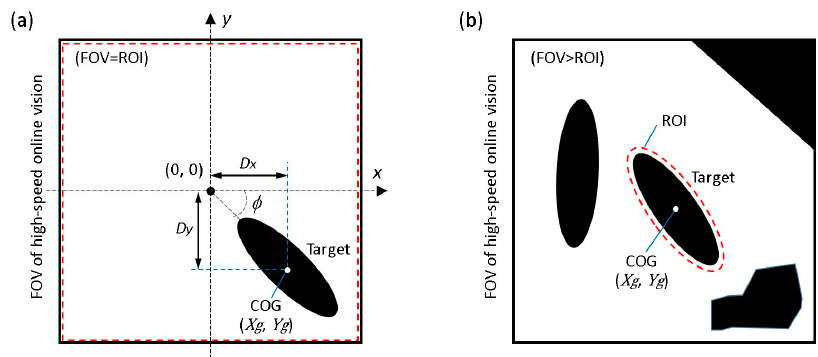
Figure 3. Image coordinate system for image processing. ( a ) Typical image processing for target tracking; ( b ) Implemented approach with an elliptical region of interest (ROI).